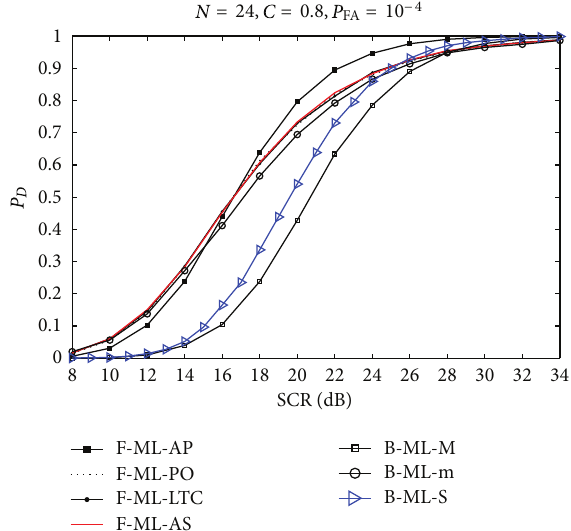
F 1: PD versus SCR performance of distributed detector based on ML CFAR algorithm in local sensors when